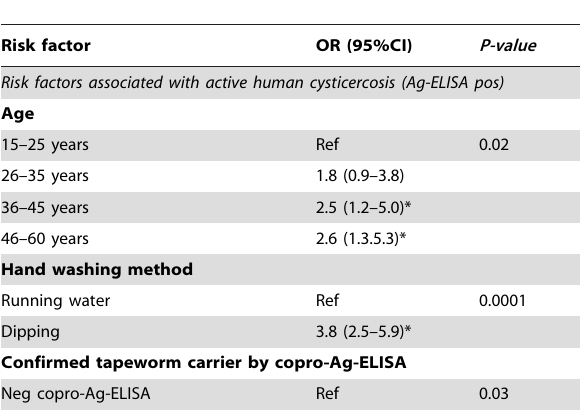
Table 3. Multivariate analysis on risk factors for human cysticercosis considered in the logistic regression